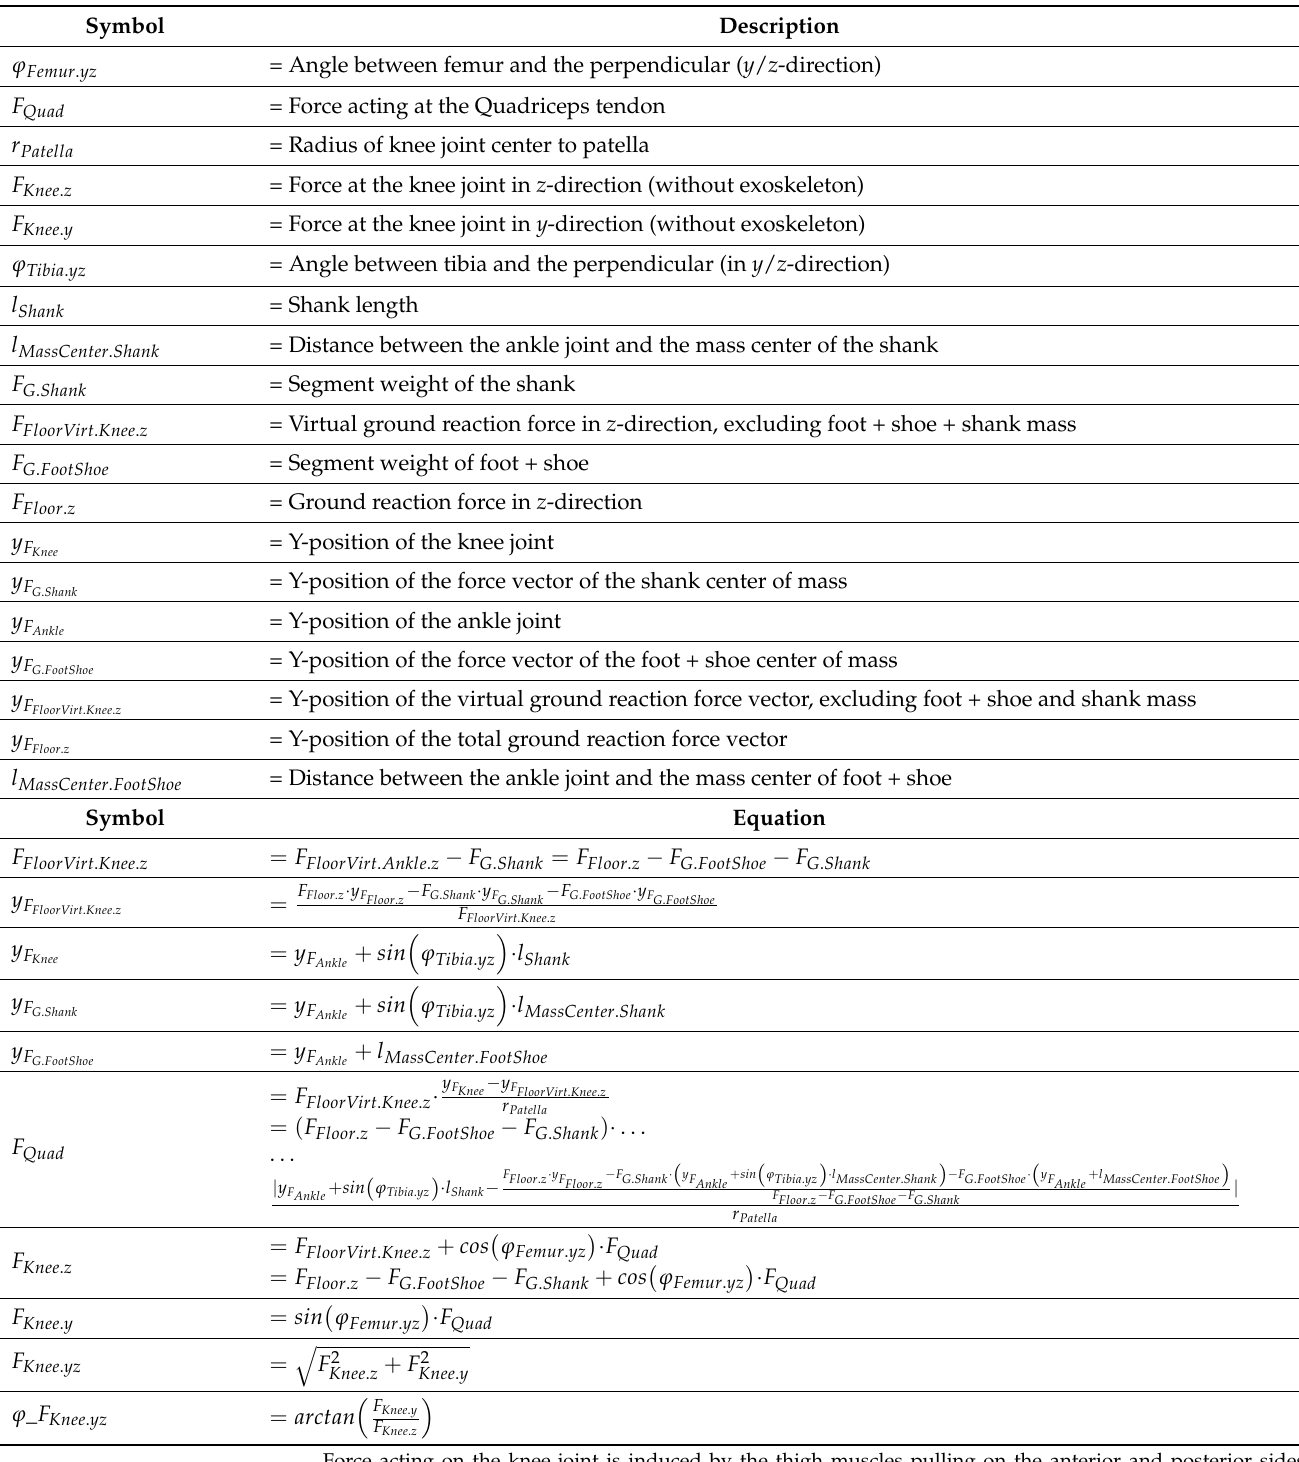
Table A3. Symbols with description and Equations as used for the model displayed in Figure A2.